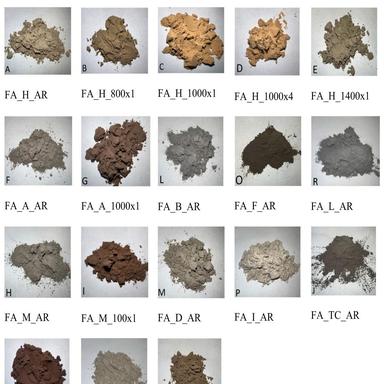
Photographs of candidate fly ashes in their as-received and – where applicable – thermally cycled states.